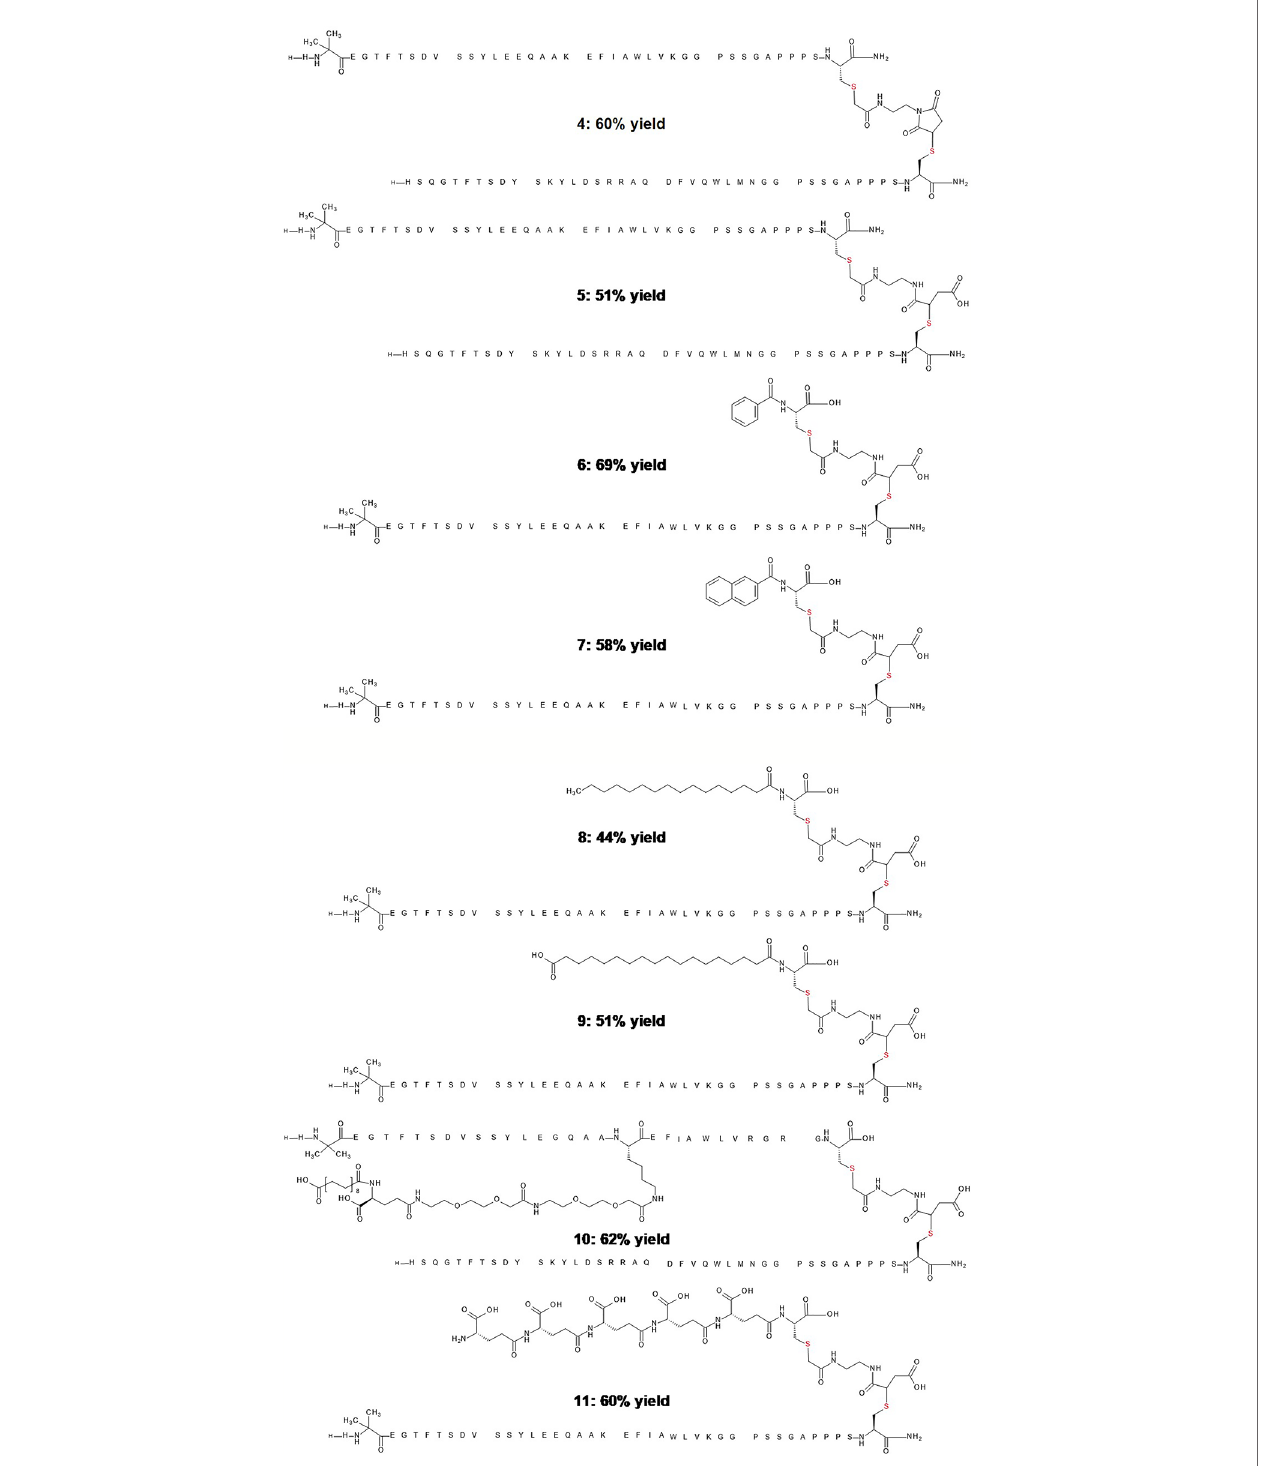
FIGURE 2 | Representative examples and yields of stably conjugated peptide dimers and other chemical derivatives. Peptide 4 is the conjugate of glucagon and GLP-1 analogs before hydrolysis. Peptide 5 is the hydrolyzed product of glucagon and GLP-1 analog. Peptide 6 is the hydrolyzed product of a GLP-1 analog and benzoic acid. Peptide 7 is the hydrolyzed product of a GLP-1 analog and 2-naphthoic acid. Peptide 8 is the hydrolyzed product of a GLP-1 analog and fatty acid C16 conjugate. Peptide 9 is the hydrolyzed product of a GLP-1 analog and fatty acid C18 conjugate. Peptide 10 is the hydrolyzed product of a glucagon analog and fatty acid protracted GLP-1analog. Peptide 11 is the hydrolyzed product of a GLP-1 analog and a pentapeptide of glutamic acid.